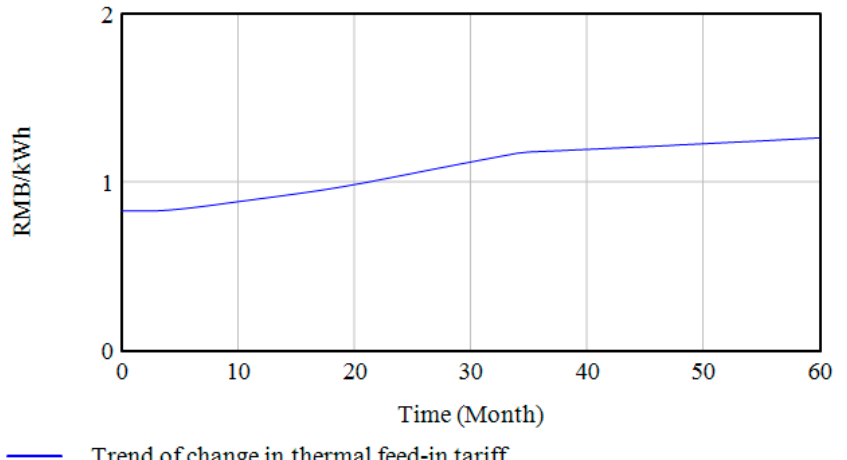
Figure 10. Trend of change in thermal feed-in tariff.